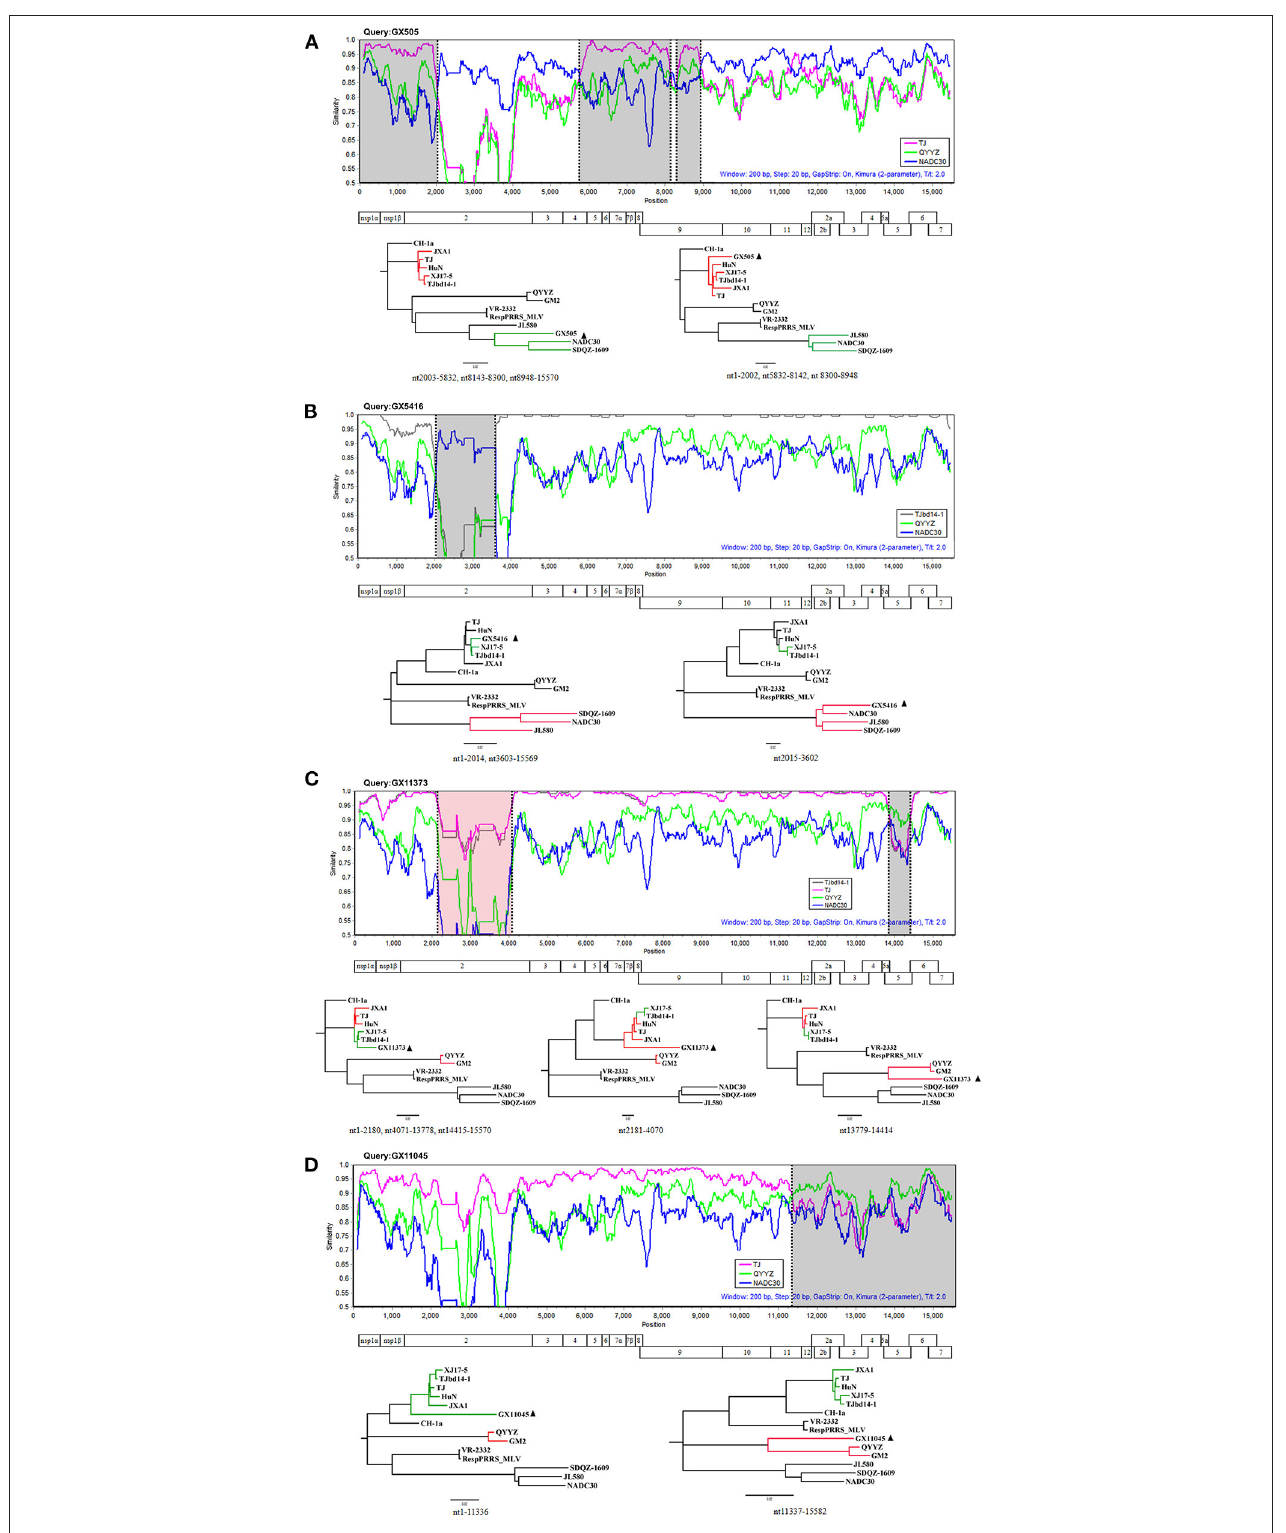
FIGURE 7 | Recombination analysis of strains GX505 (A) , GX5416 (B) , GX11373 (C) , and GX11045 (D) . Genome scale similarity comparison of the isolates (query) with TJ (orange), TJbd14-1 (gray), NADC30 (blue), and QYYZ (green). Recombination breakpoints are shown as black dashed lines. The background color of